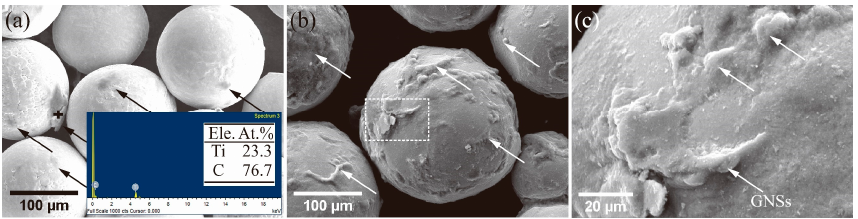
Figure 9. SEM images of #3 GNS/Ti64 composite powders by planetary BM ( a , b ) and the magnified box ( c ).